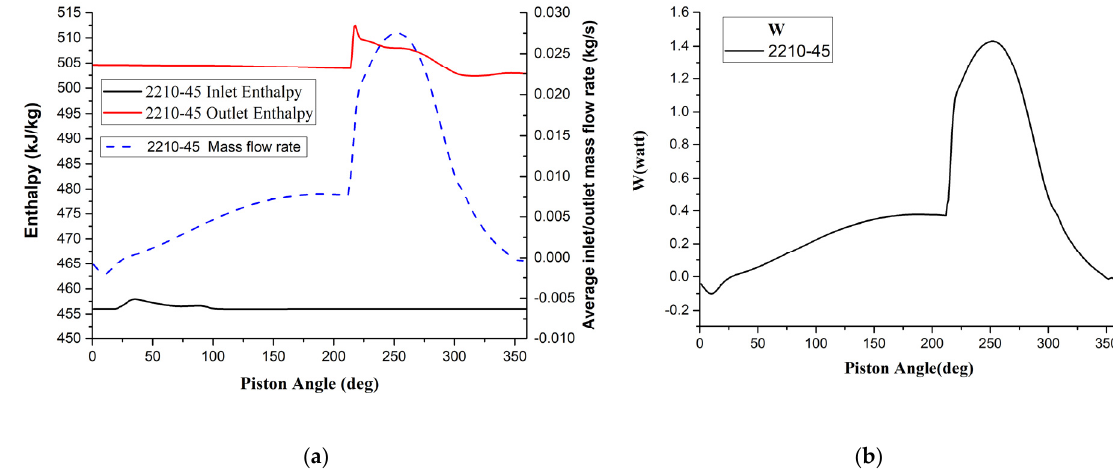
Figure 9. Enthalpy and work: ( a ) enthalpy at inlet / outlet and average mass flow rate, ( b ) instantaneous work done on the refrigerant.